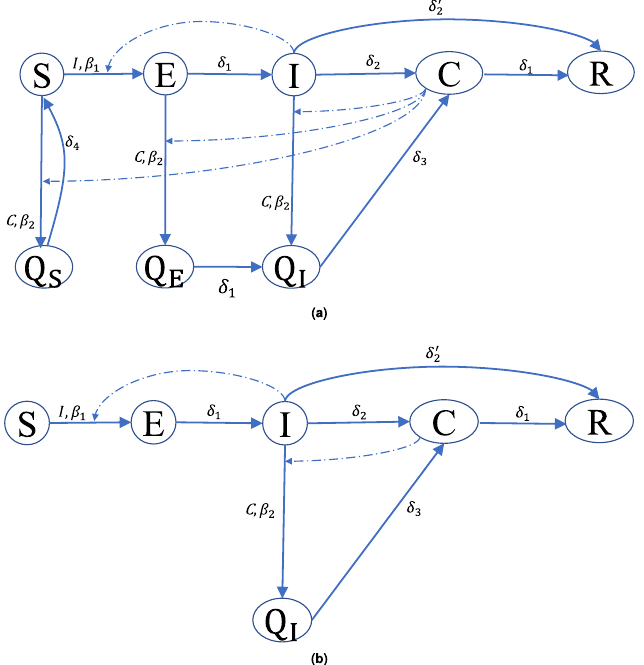
Figure 8. Node transition diagrams. ( a ) SEICQ1 epidemic model, ( b ) SEICQ2 epidemic model. The solid lines represent the node-level transitions, and the dashed lines represent the influence of the influencer compartment on an edge-based